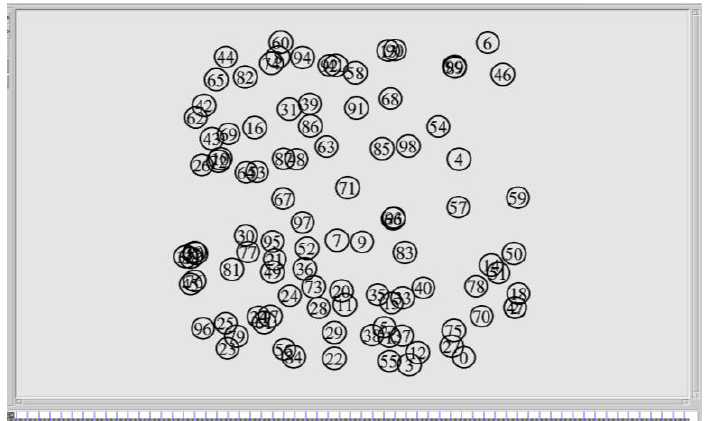
Figure 10. Random distribution map of 100